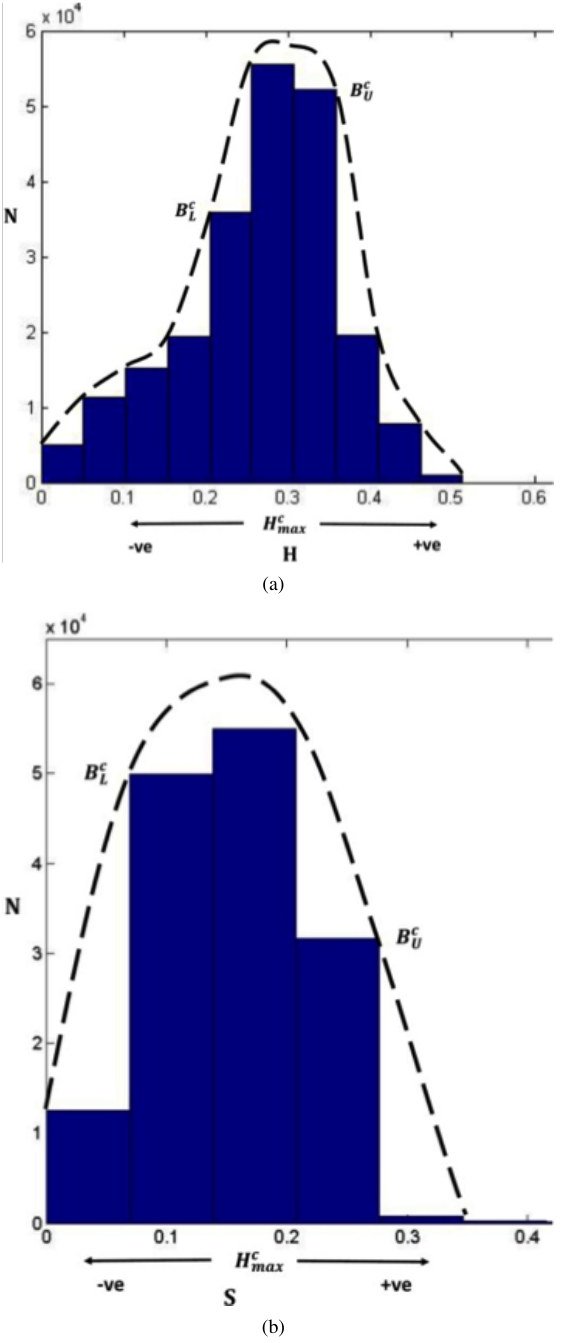
Figure 3. (a) and (b) show the histogram distribution for H and S respectively for 3D points of a selected zone. Based on the dominant peaks, B c and B c are automatically selected. U L